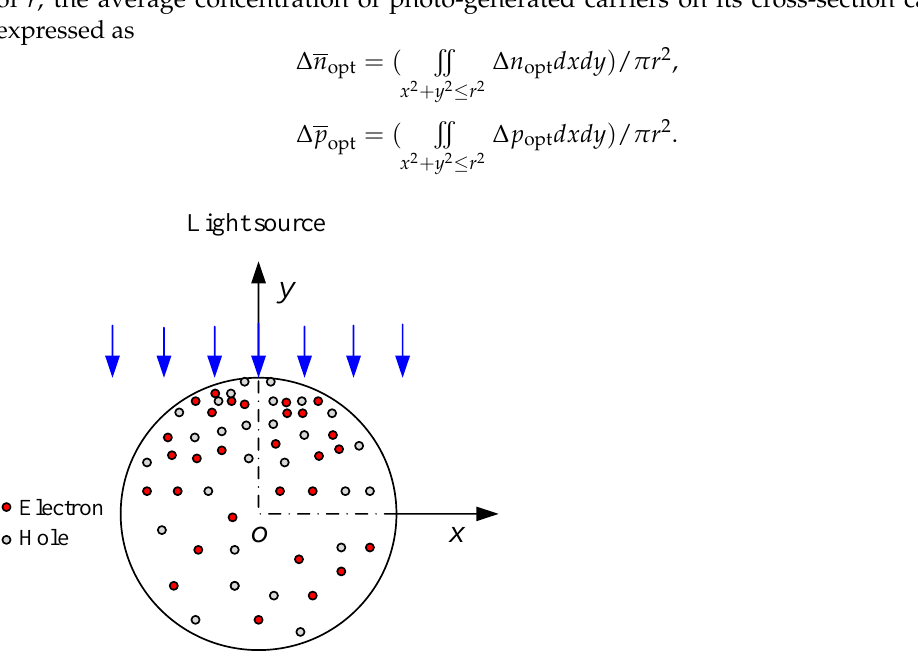
Figure 1. A schematic attenuation diagram of photoexcited carriers with the transmission depth under incident light.